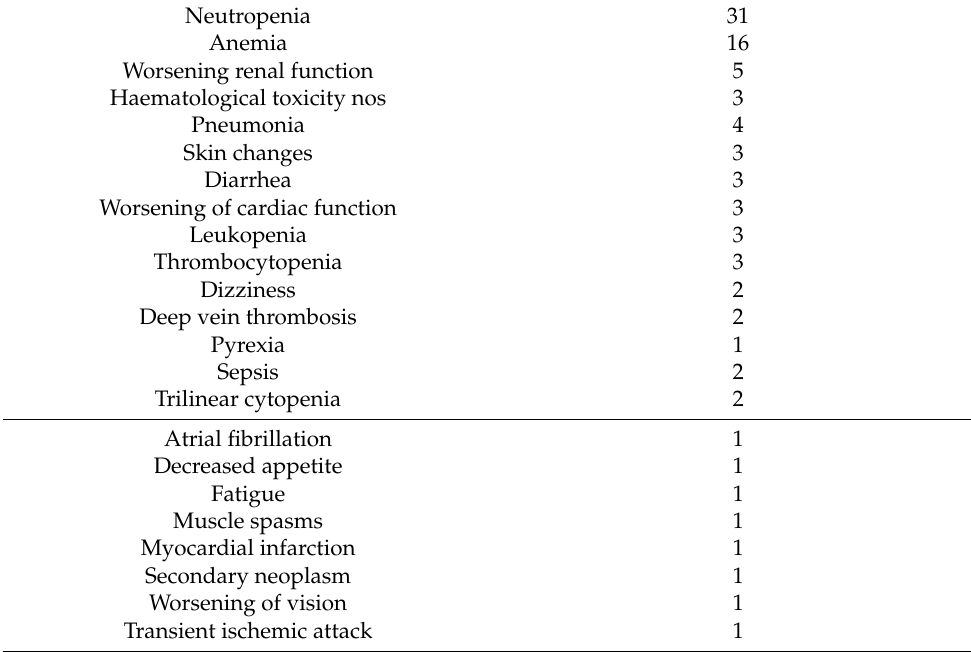
Figure 1. Summary of median OS and PFS analysis. III and IV-VII indicate the line of therapy in which POM-DEX was used. PFS, progression-free survival; OS, overall survival. Tot., total; co., POM-DEX course/courses. 203 Table 4. Summary of the most commonly reported adverse